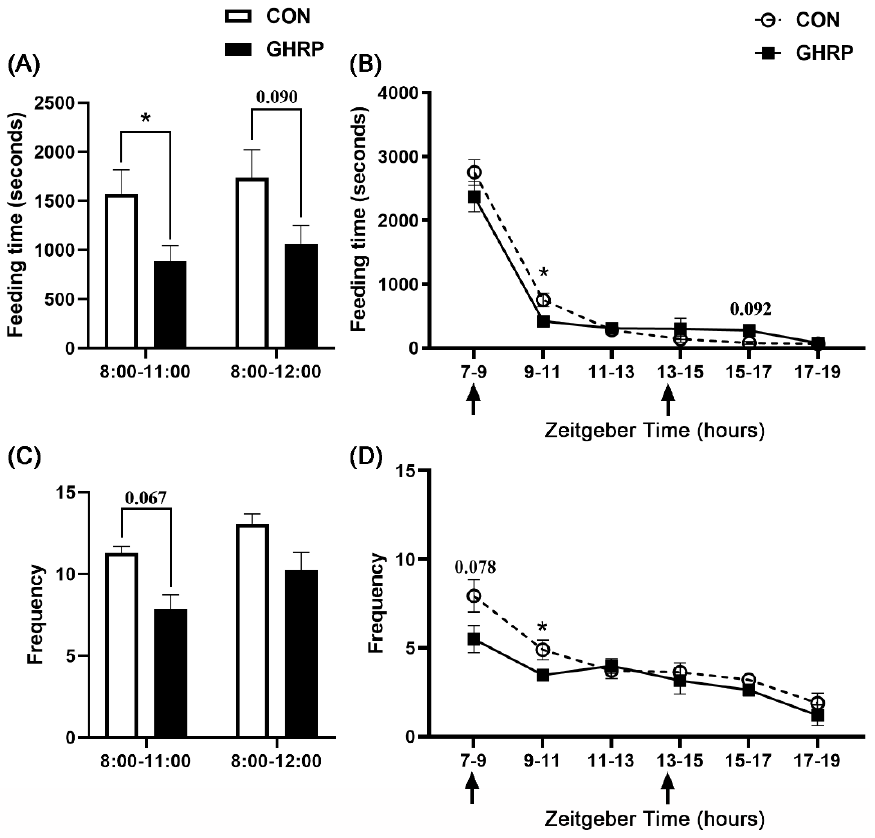
Figure 4. Injection of ghrelin antagonist ([D-Lys3]-GHRP-6) affected the feeding behavior of pigs. The total feeding time ( A ) and frequency ( C ) from 8:00 to 11:00 and from 8:00 to 12:00, and the feeding time ( B ) and frequency ( D ) every 2 hours from 7:00 to 19:00 over the 7 d trial period, were counted. Values are means ± SEMs; n = 6. * p < 0.05 versus control group. The arrow indicates injection of [D-Lys3]-GHRP-6 (GHRP) or saline (CON).